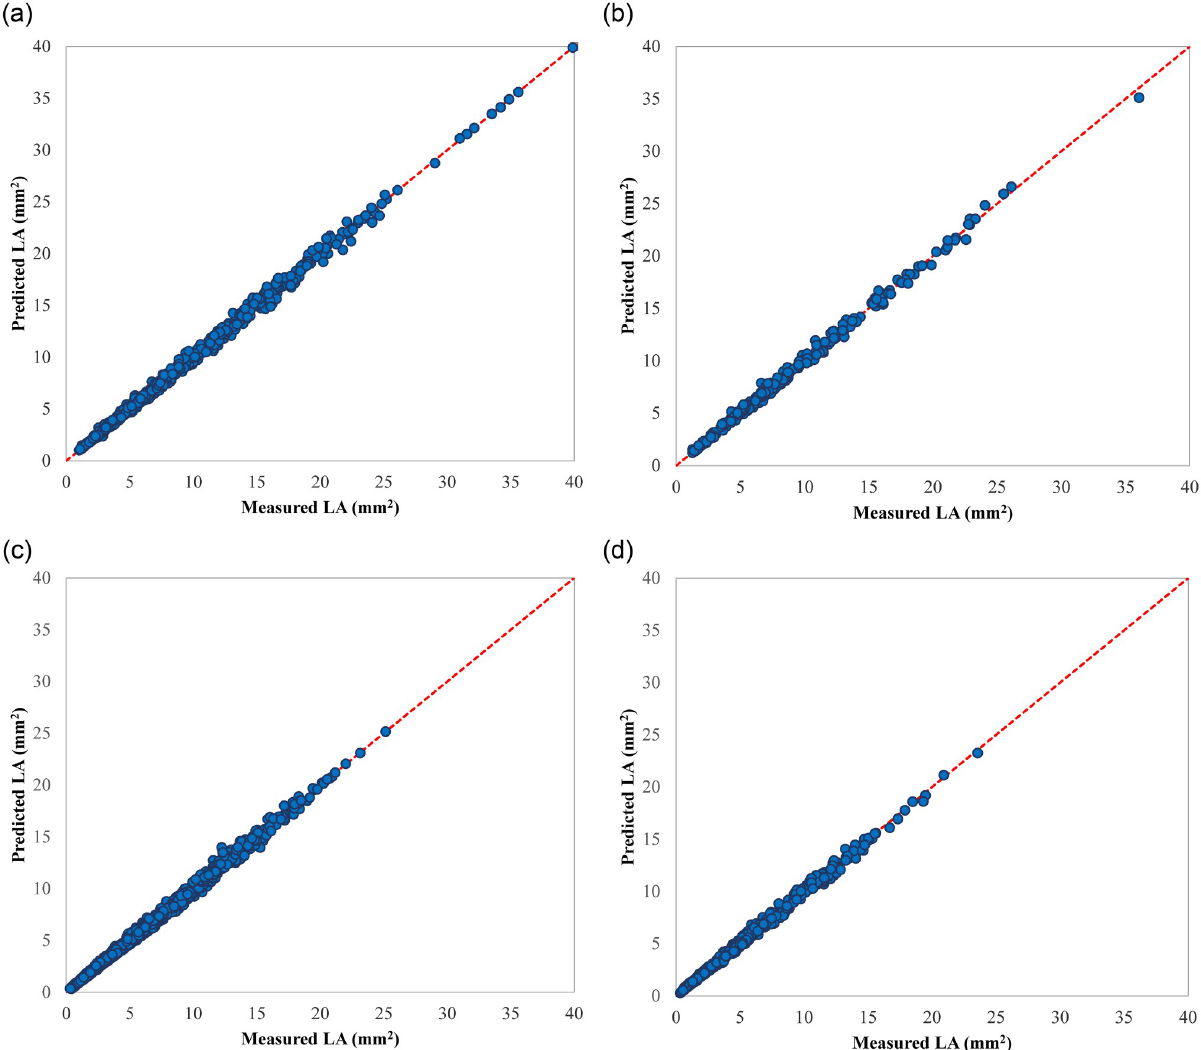
Fig 11. Scatters plot of measured vs. estimated LA values of selected ANFIS models; a) the 2019 data-driven ANFIS on the training dataset, b) the 2019 data-driven ANFIS on the test dataset, c) the 2021 data-driven ANFIS on the training dataset, and d) the 2021 data-driven ANFIS on the test dataset.